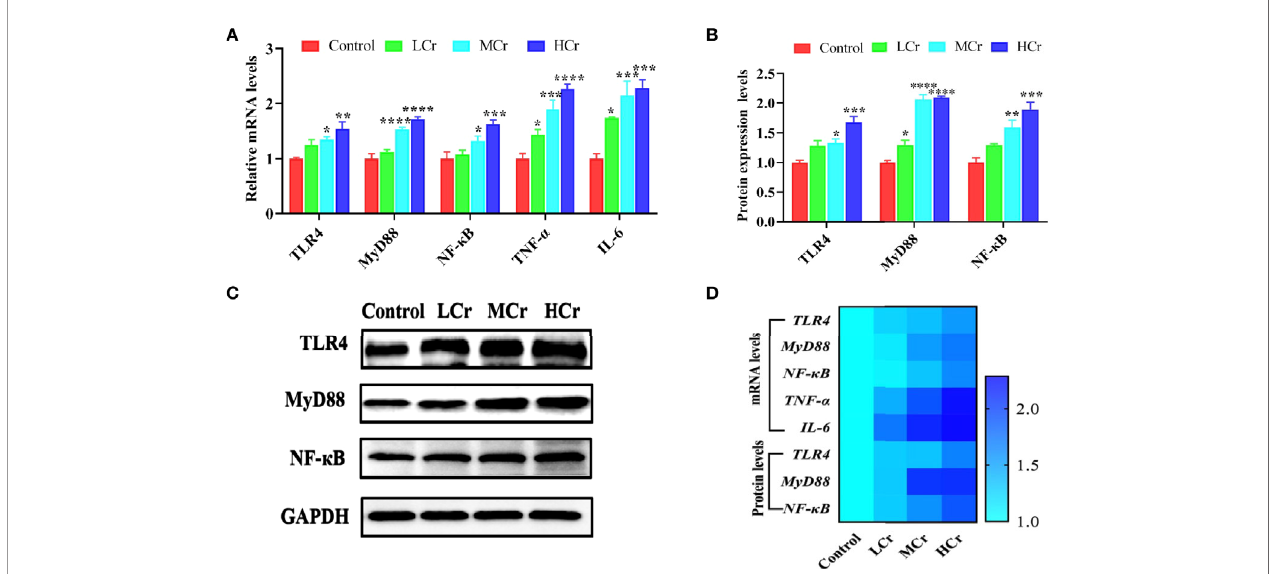
FIGURE 4 | The in fl uence of Cr(VI) on the NF- k B signaling pathway in jejunum tissues. (A) mRNA levels of genes involved in the NF- k B signaling pathway. (B) Quantitative analysis of NF- k B signaling pathway-related protein expression. (C) Western blot reveals that expression levels of NF- k B signaling pathway-related proteins. (D) A heatmap depicts the relationship between NF- k B signaling pathway-related mRNA and protein levels in jejunum tissues. The symbol “ * ” denotes a statistically signi fi cant difference from the control group (* P < 0.05, ** P < 0.01, *** P < 0.005 and **** P <